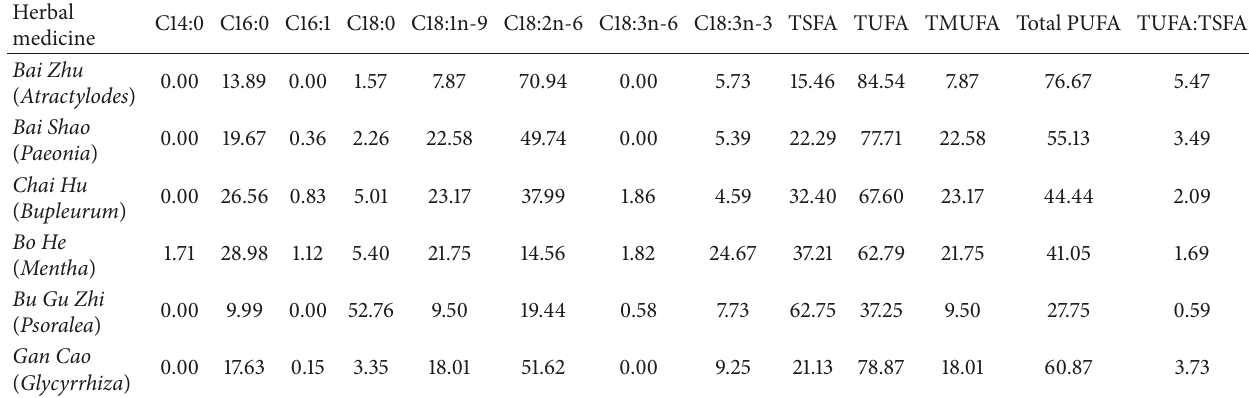
Values are mean of three replicates; ND: not detectable. Table 5: Fatty acid profiles of herbal medicine extracts (based on